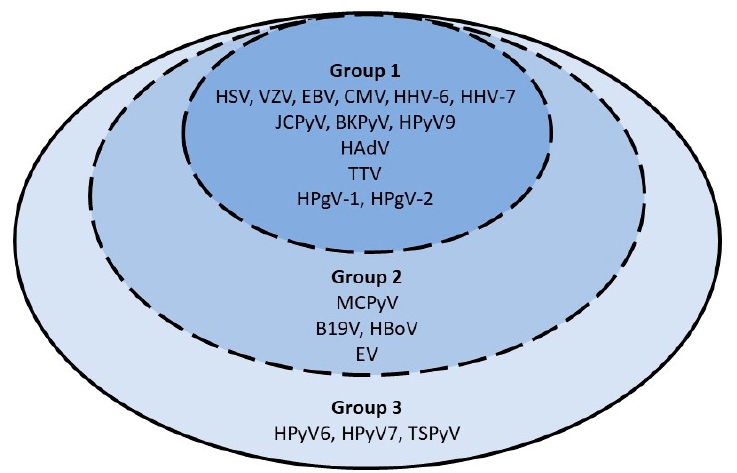
Figure 1. Priority order for virological testing on plasma samples. Patients in group 3 had screening for all 20 viral species (comprising viral species of groups 1, 2 and 3). Patients in group 2 were screened for 17 viral species (comprising viral species of group 1 and 2). Patients in group 1 were screened for 13 viral species only. Abbreviations: HSV-1/2: herpes simplex virus; VZV: